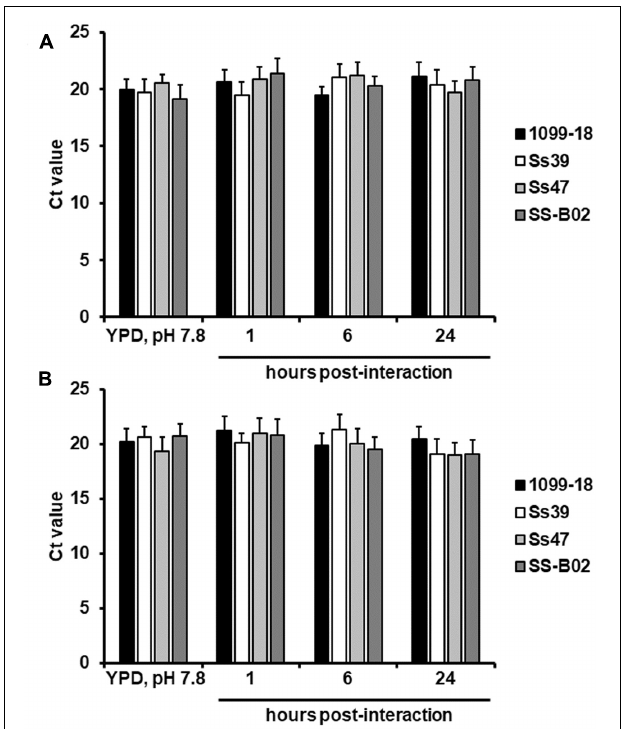
FIGURE 4 | Ct values of the S. schenckii sensu stricto gene encoding for the ribosomal protein L6 upon interaction with human PBMCs and the RAW 264.7 (ATCC R (cid:13) TIB-71 TM ) murine cell line. Sporothrix yeast-like cells were obtained in YPD broth, pH 7.8, and used to interact with either human PBMCs (A) of RAW 264.7 (ATCC R (cid:13) TIB-71 TM ) murine cell line (B) . Fungal cells were retrieved after 1, 6, or 24 h interaction with the immune cells, total RNA was extracted, cDNA synthesized with oligo(dT) primer (20 mer) and the gene expression was quantified by RT-qPCR using specific primers (see Table 1 ). One-way ANOVA was used to establish statistical significance. P -value was for all the strains >